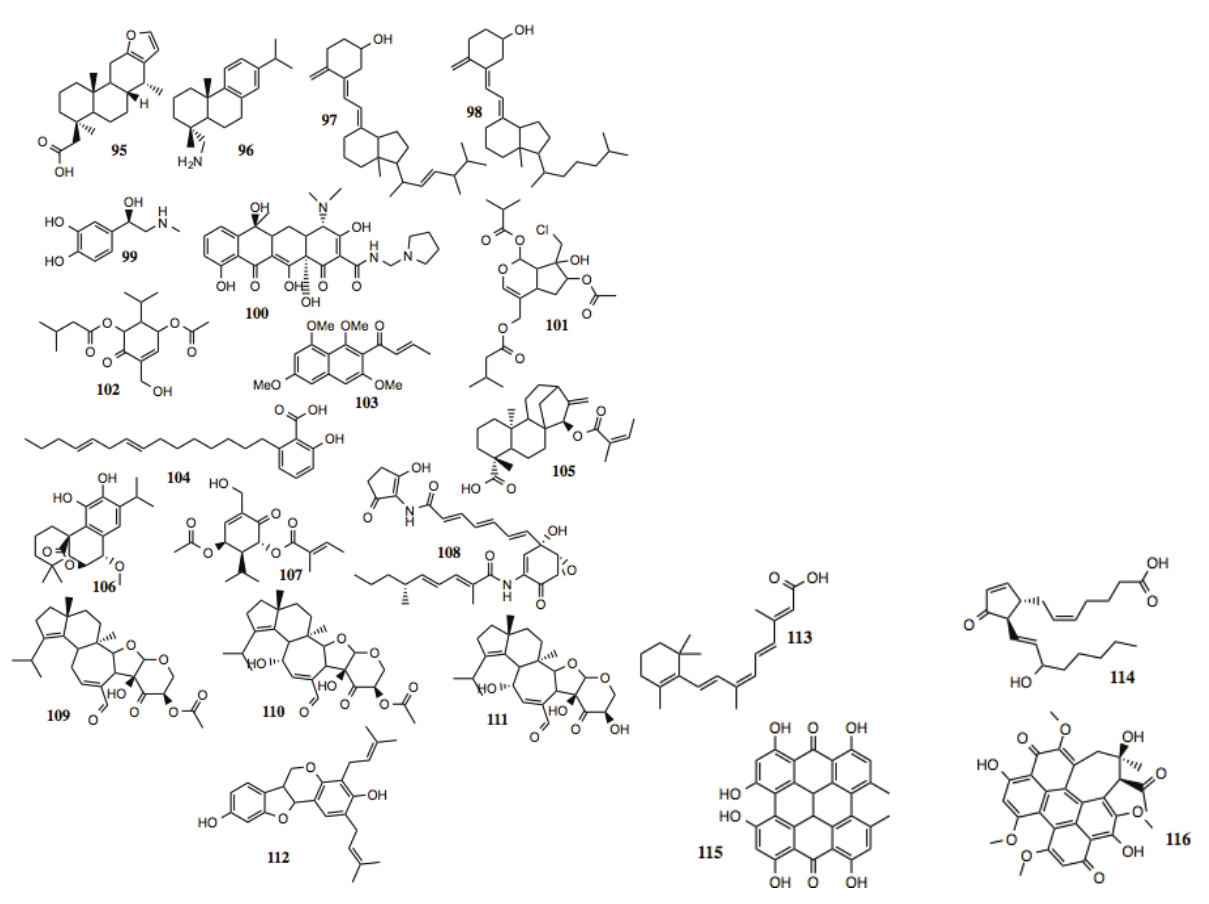
Figure 11. Other miscellaneous